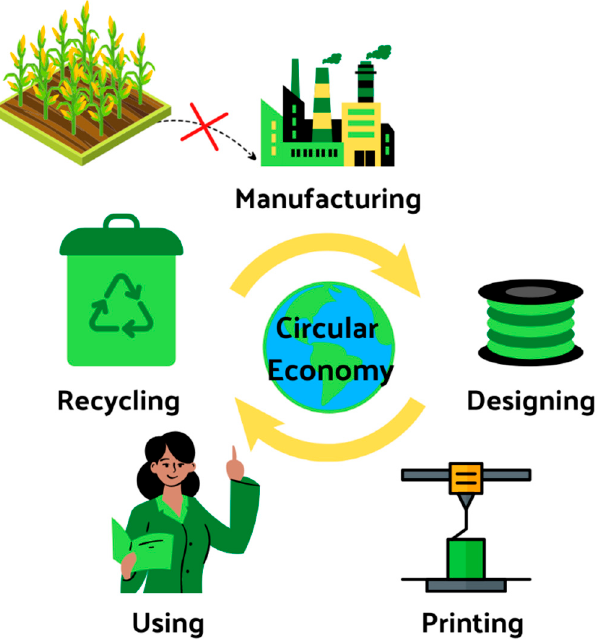
Figure 3. The life cycle of the raw material in a closed cycle—it is necessary to eliminate the need new resources for new resources [158].